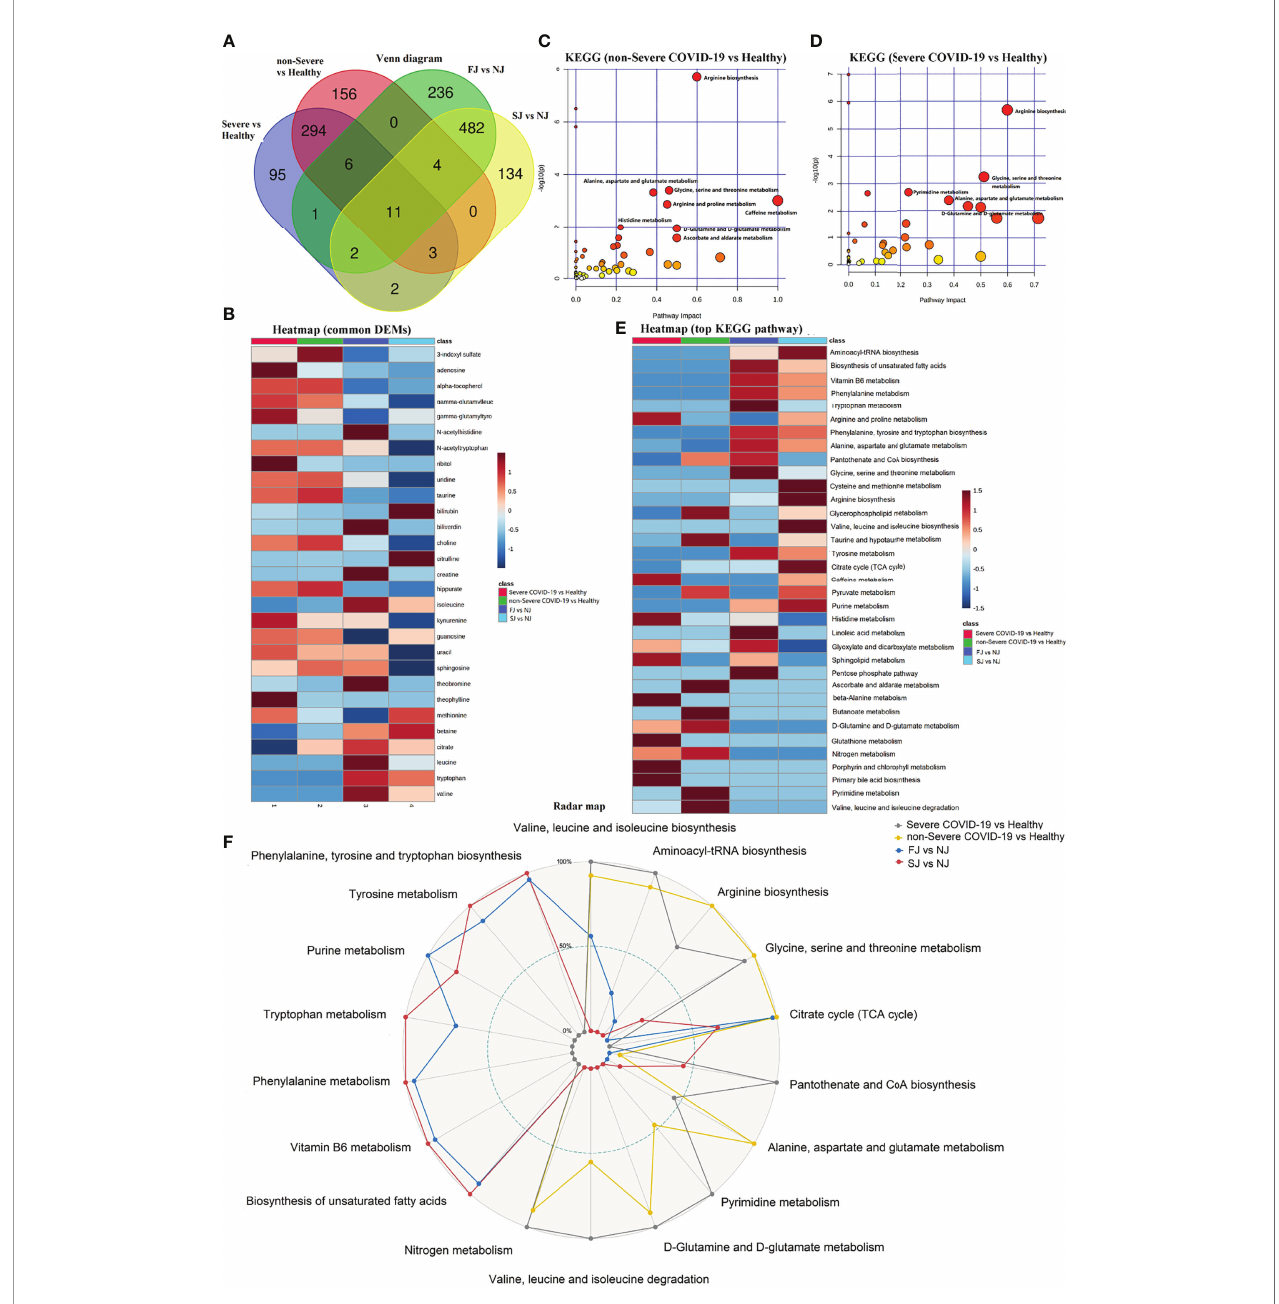
FIGURE 8 | Comparison of DEMs and their enriched pathways in severe COVID-19 infection, non-Severe COVID-19 infection, FJ and SJ group. (A) Venn diagram showing the number of DEMs from severe COVID-19 vs healthy, non-Severe COVID-19 vs healthy, FJ vs NJ, and SJ vs NJ. (B) Heatmap of the common metabolites shared between CoronaVac immunization and infection. (C) KEGG pathway analysis of DEMs from severe COVID-19 vs healthy. (D) KEGG pathway analysis of DEMs from non-Severe COVID-19 vs healthy. (E) Heatmap of the top KEGG terms enriched from DEMs in severe COVID-19 vs healthy, non-Severe COVID-19 vs healthy, FJ vs NJ and SJ vs NJ. (F) Radar map of the top KEGG terms enriched from DEMs in severe COVID-19 vs healthy, non-Severe COVID-19 vs healthy, FJ vs NJ and SJ vs NJ, respectively. -Log 10 p values of KEGG terms were used to make the radar